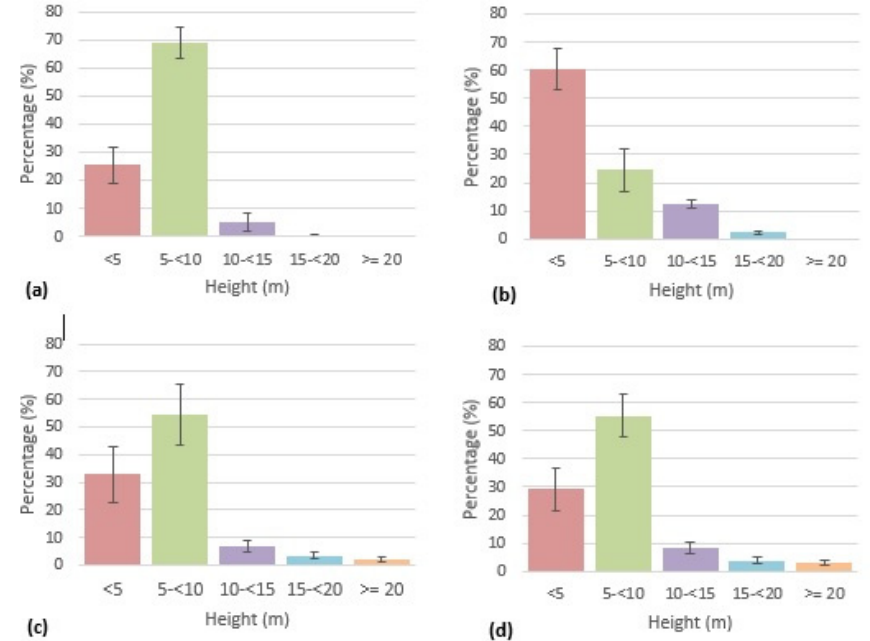
Fig. 7: Height distributions of stands at peat depths of <50 cm (a), 393‐<479 cm (b), 479‐<565 cm (c), and ≥565 cm (d) (error bars represent std. errors of means).